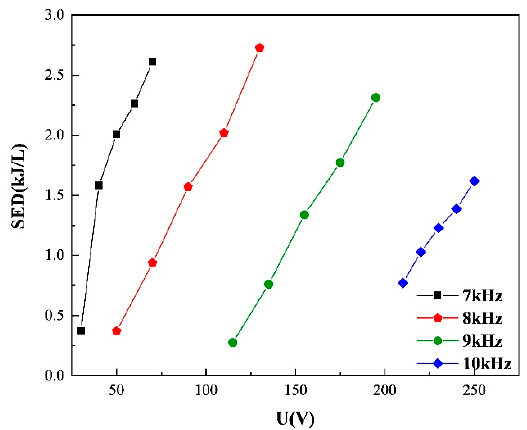
Figure 4. The variation of DBD discharge density with discharge voltage under different discharge frequencies.